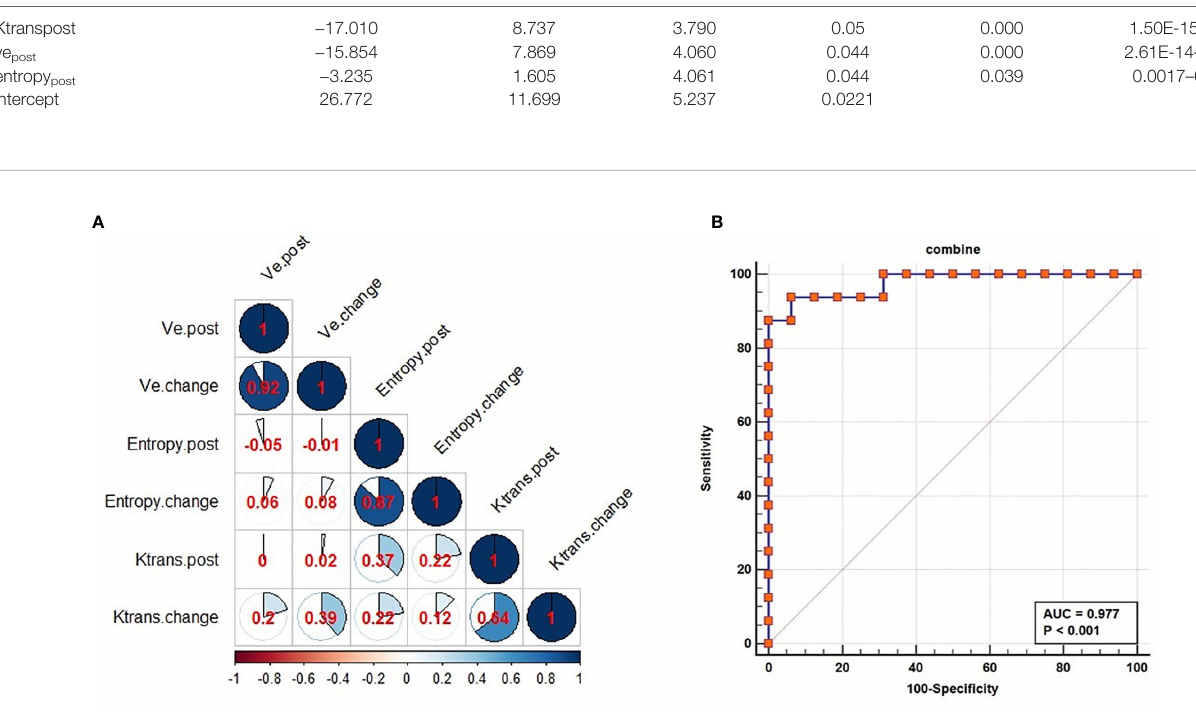
TABLE 4 | Performance of a logistic regression model with a combination of Ktrans, Ve and Entropy. Quantitative Parameters